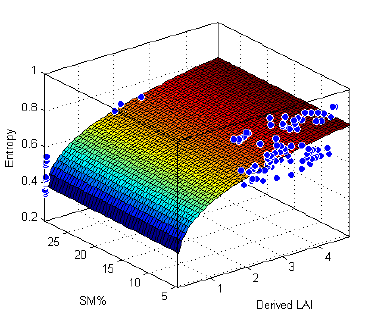
Figure 4. Map of LAI from